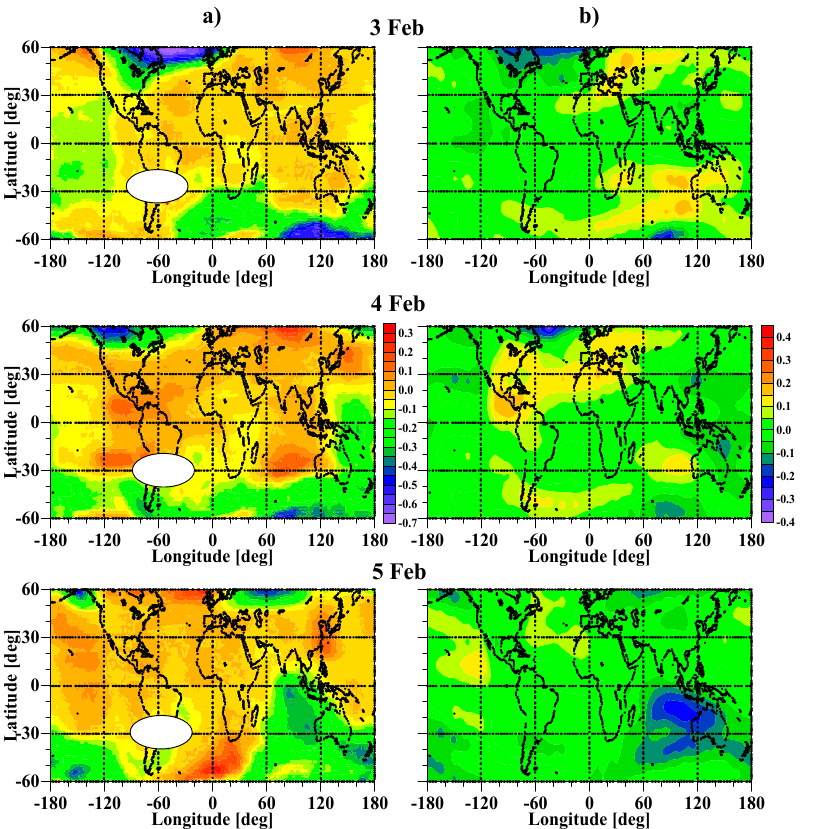
Figure 14. ( a ) Relative deviations of O/N 2 from medians and ( b ) relative TEC for fixed local time 16 LT on 3, 4, and 5 February 2022.